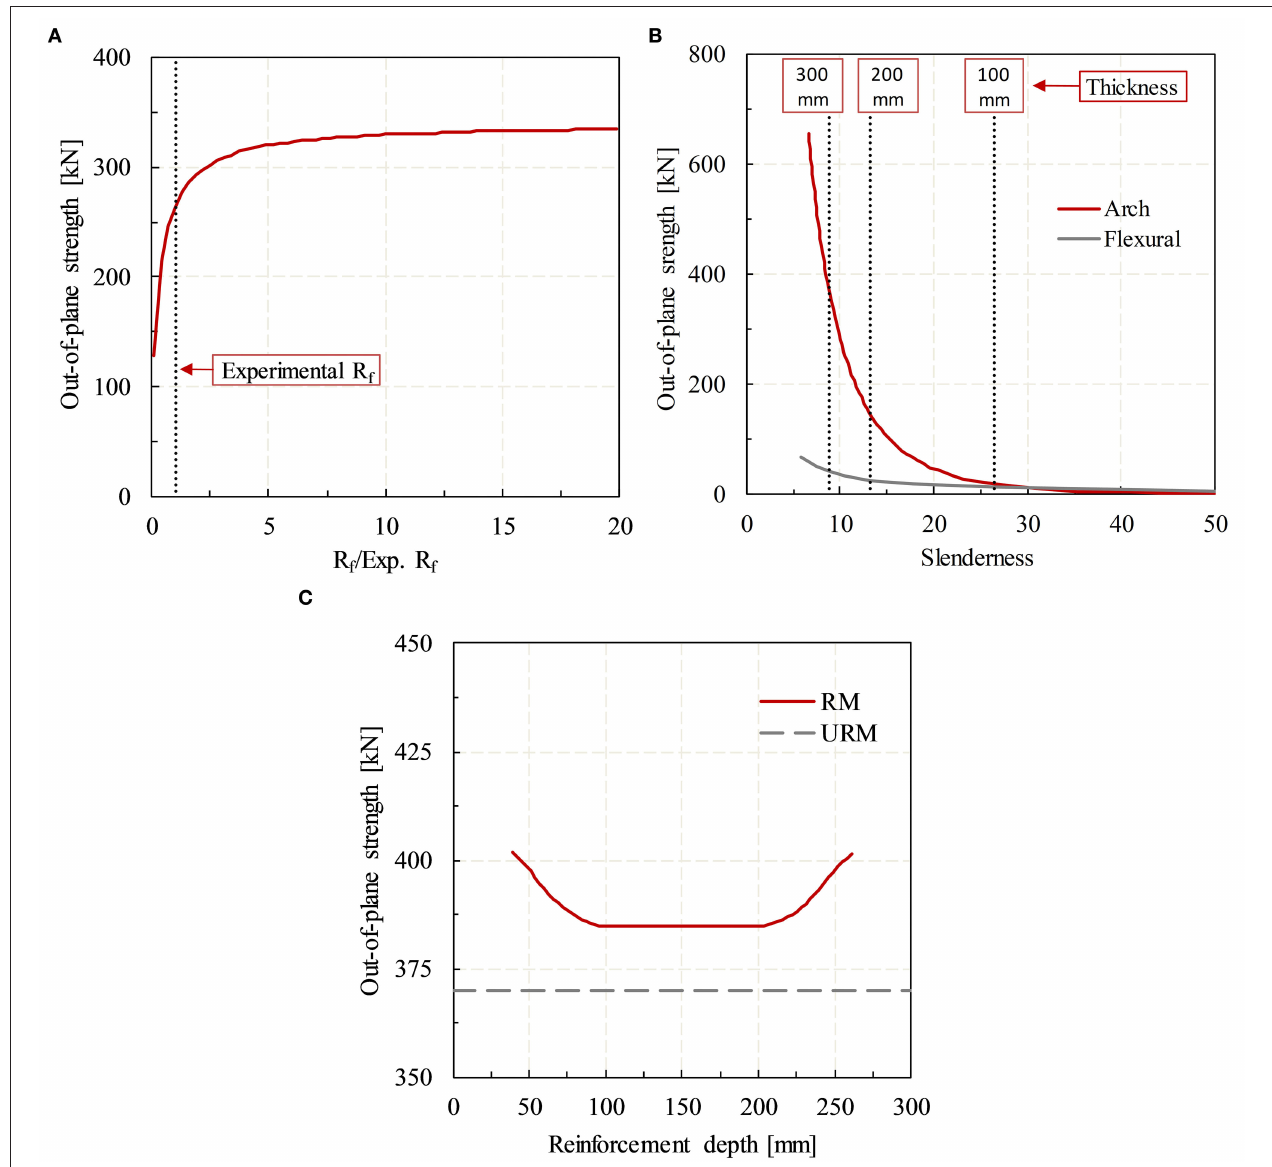
FIGURE 20 | Infill out-of-plane maximum strength as a function of reinforced concrete beam stiffness (A) , infill slenderness (B) , and vertical reinforcement bar depth (C) .